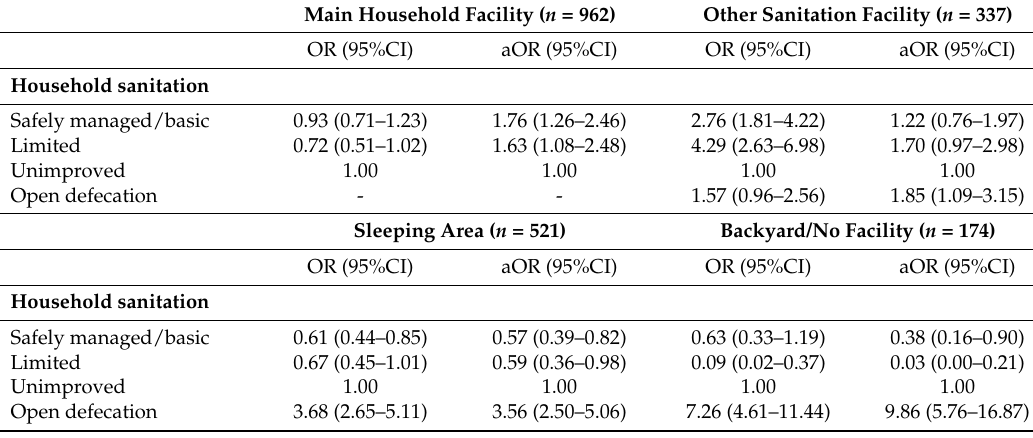
Table 2. Bivariate and multivariable relationships between household sanitation and menstrual management